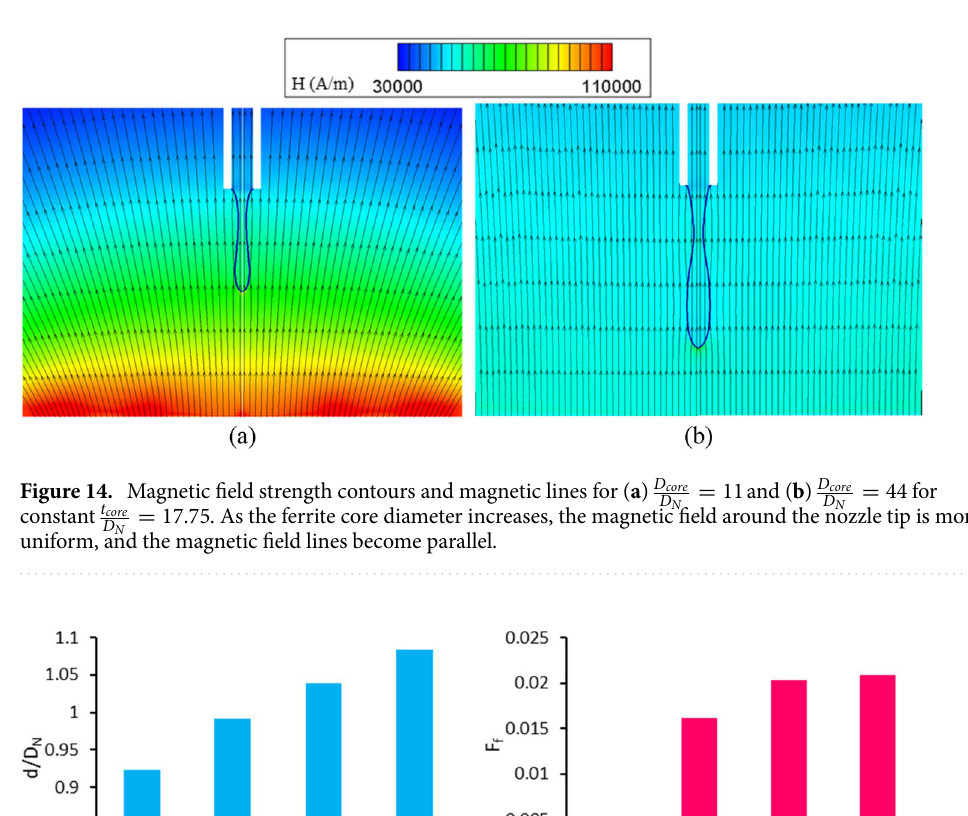
Figure 15. Variations of ( a ) the dimensionless diameter and ( b ) the dimensionless formation frequency in terms of the nozzle’s inner to the outer diameter